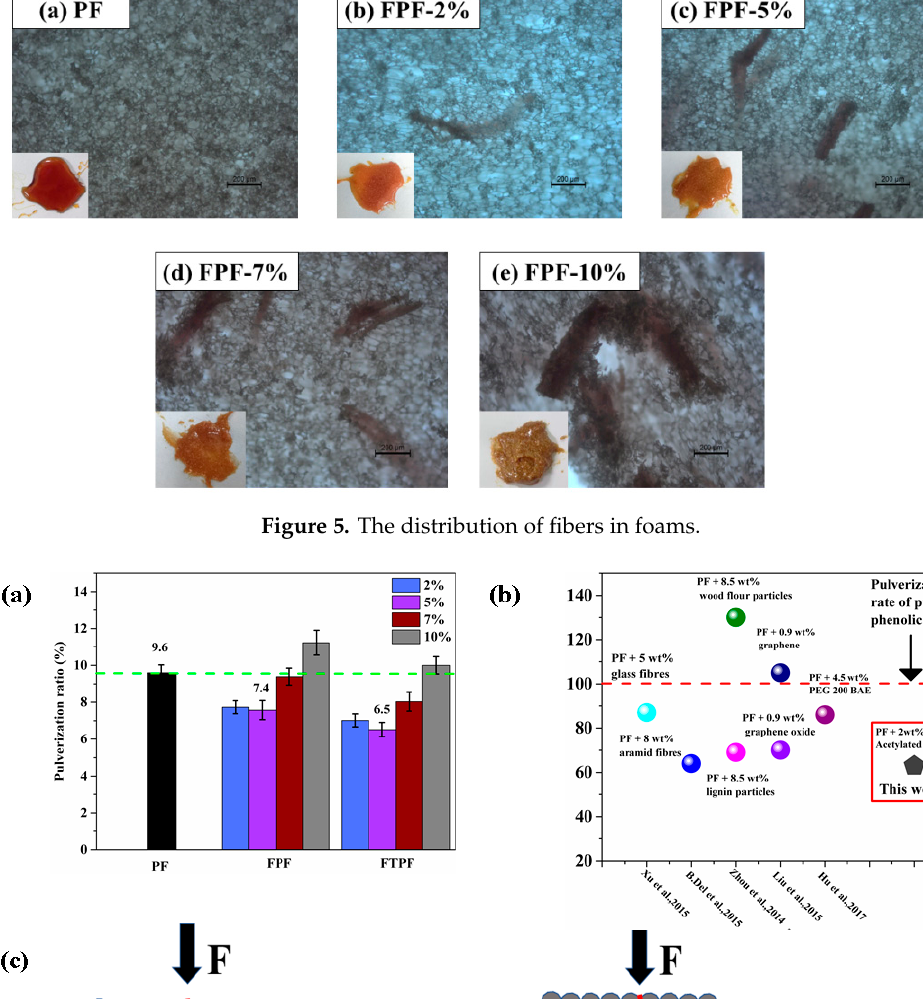
Figure 4. Normalized ( a ) compressive strength and ( b ) compressive modulus of PF, FPFs, and FTPFs.